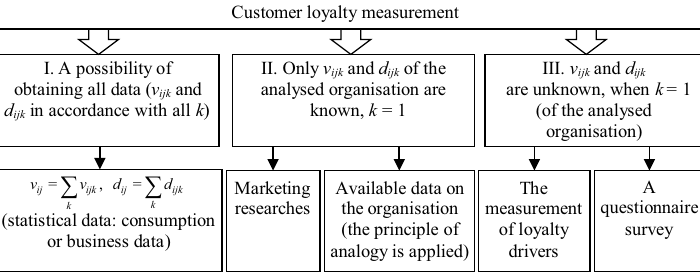
Fig. 3. Options for measuring customer